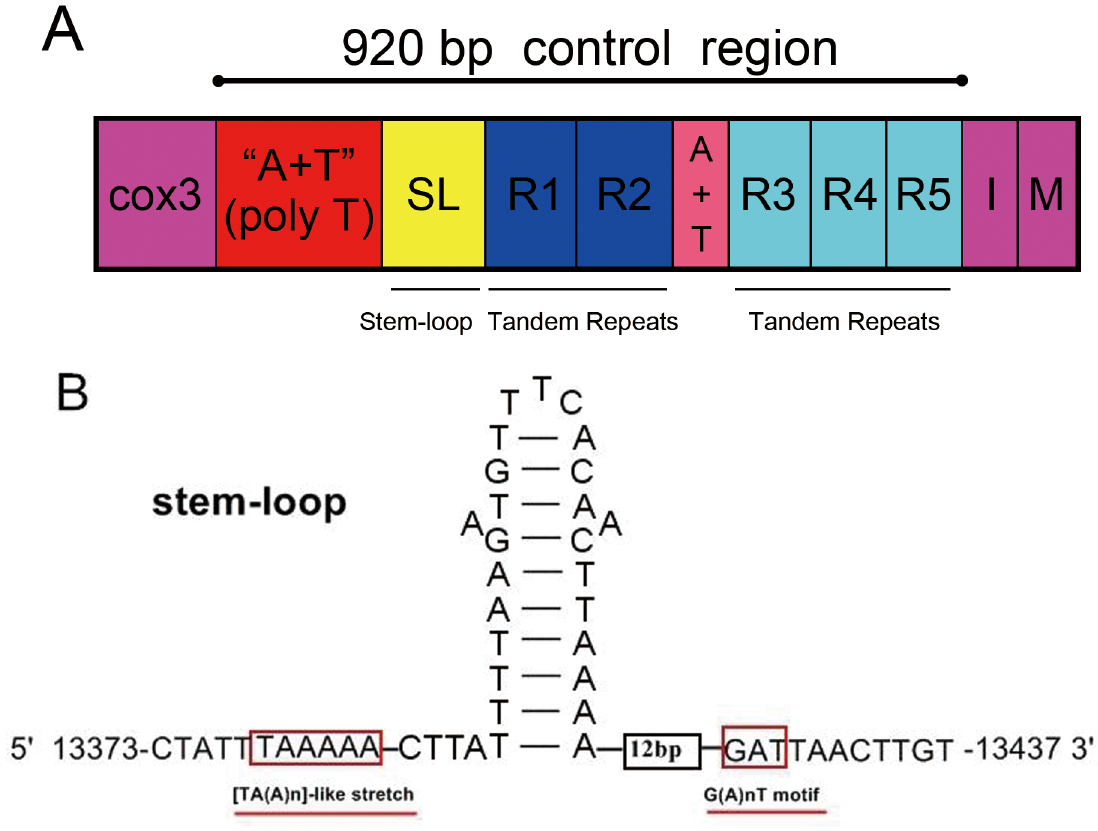
Fig 7. Predicted structural elements in the control region of A . spiniferus . (A) The control region flanking genes cox3 , trnI (I) and trnM (M) is represented by a purple shaded rectangle. The A+T regions are indicated by red and pink shaded rectangles. The yellow shaded box indicates stem-loop regions; dark blue and aqua shaded boxes represent the five tandem repeats, R1-R5. (B) Putative stem-loop structures found in the control region. The red outlined boxes indicate highly-conserved flanking